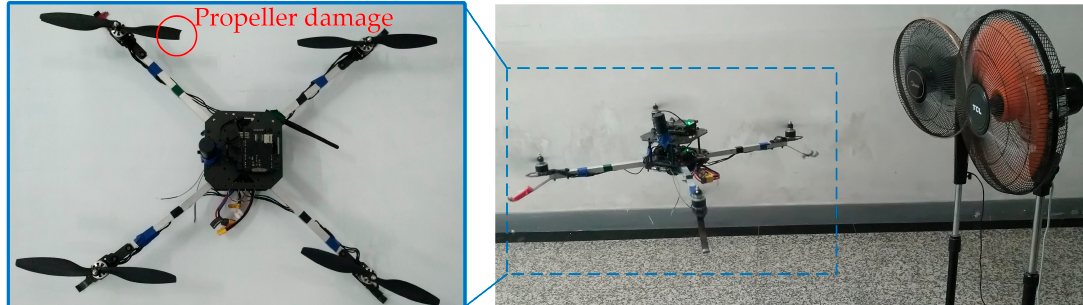
Figure 28. Experimental environment with wind and damaged propeller.